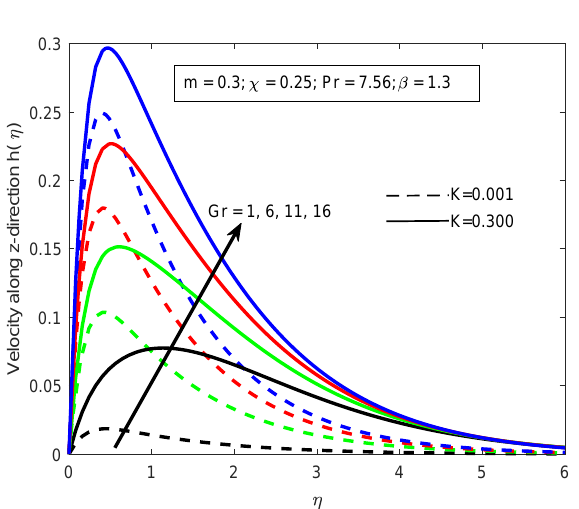
Figure 21: Variation of velocity profile in the z -direction with